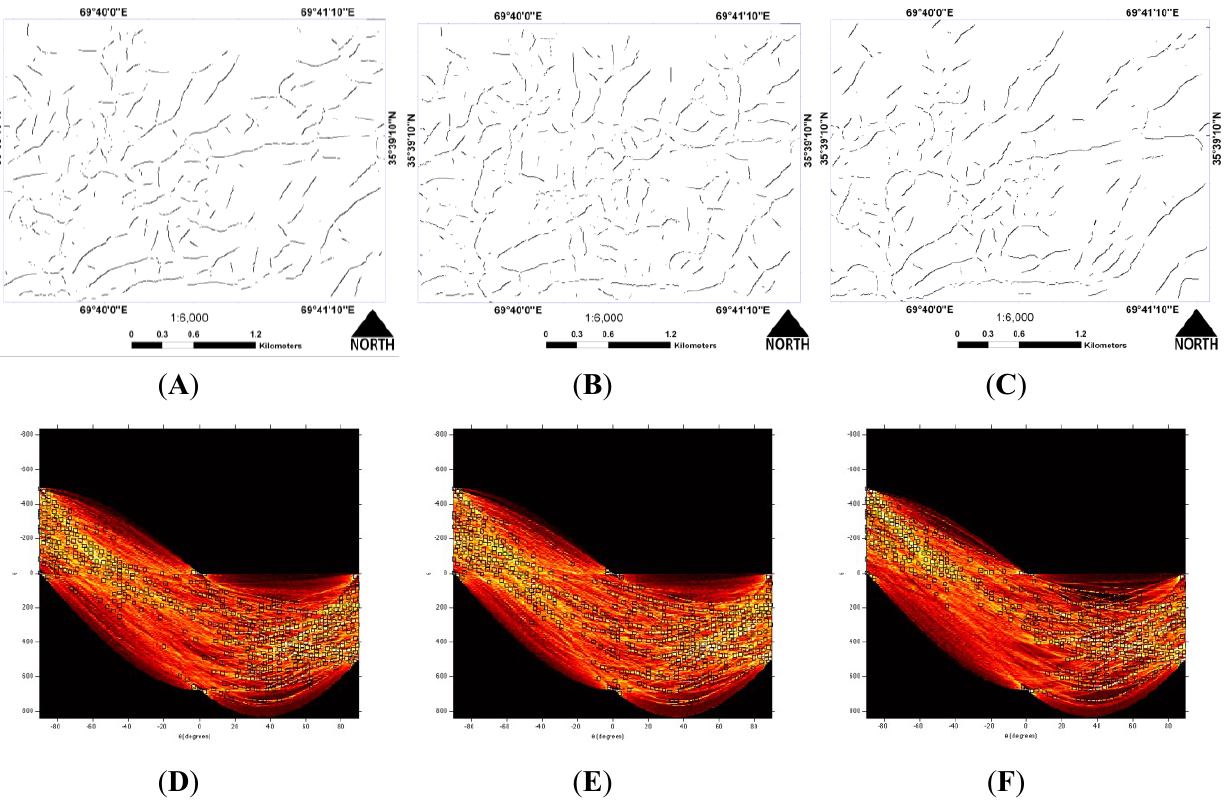
Figure 11. ( A – C ) The binary edge datasets that are produced by Sobel, LOG and Canny edge detection methods and tensor voting, respectively. ( D – F ): Hough domains from Sobel, LOG and Canny binary edge maps, respectively. Points on (D–F) images show peak values in matrix H.